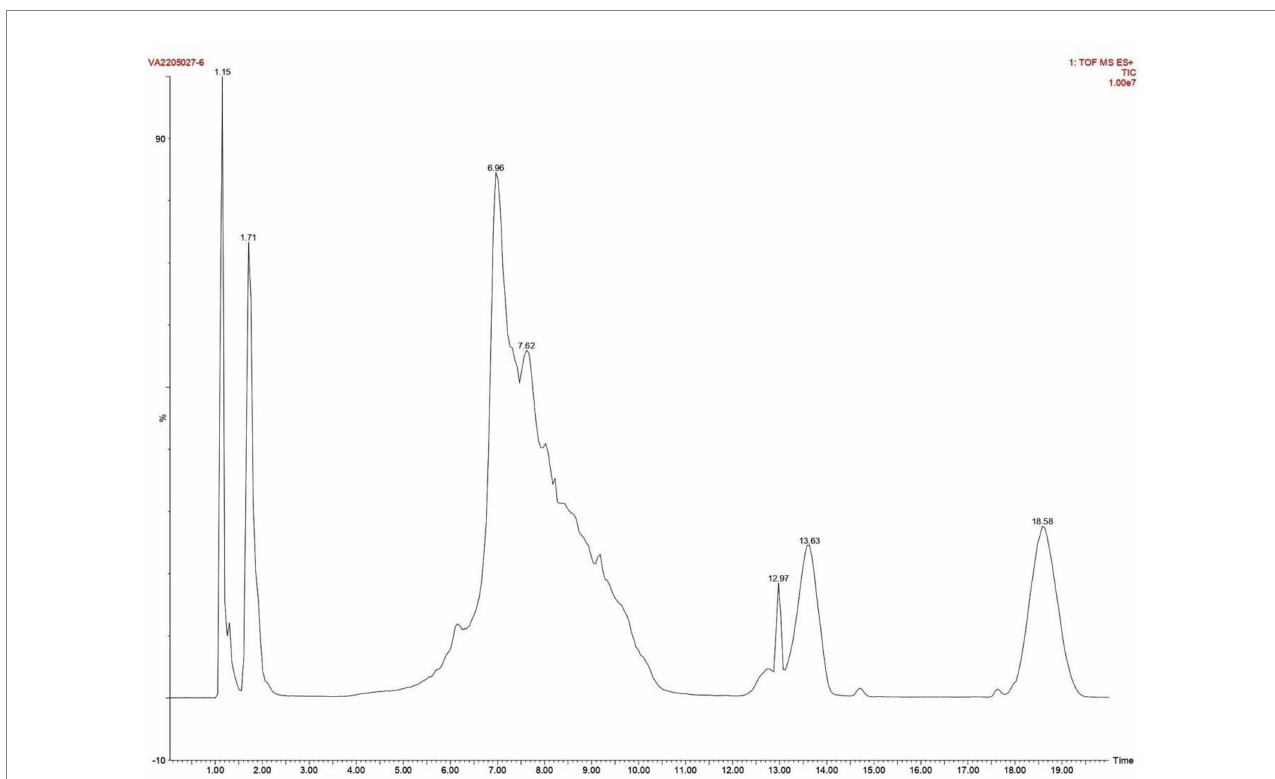
FIGURE 6 Elution profile of intracellular protein extract from Glutamicibacter mysorens by